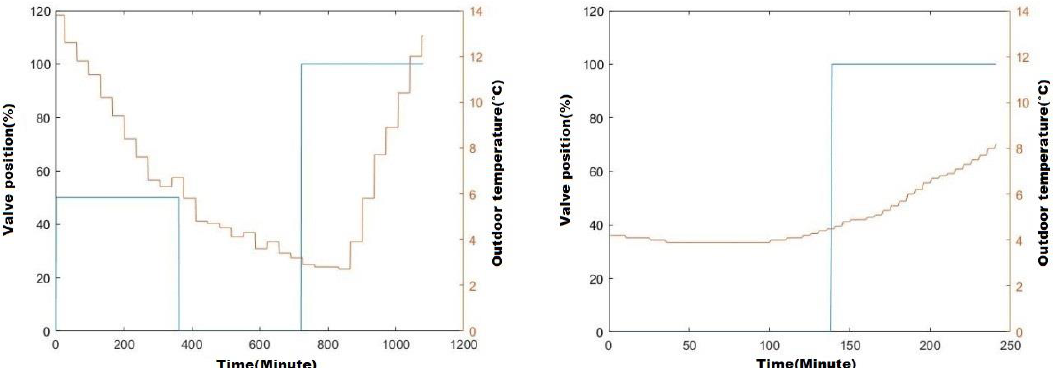
Figure 4. Experimental data collection conditions comply with the empty working space (left-side diagram) and fully occupied working space (right-side diagram), respectively, showing the valve position and outdoor temperature–time history.